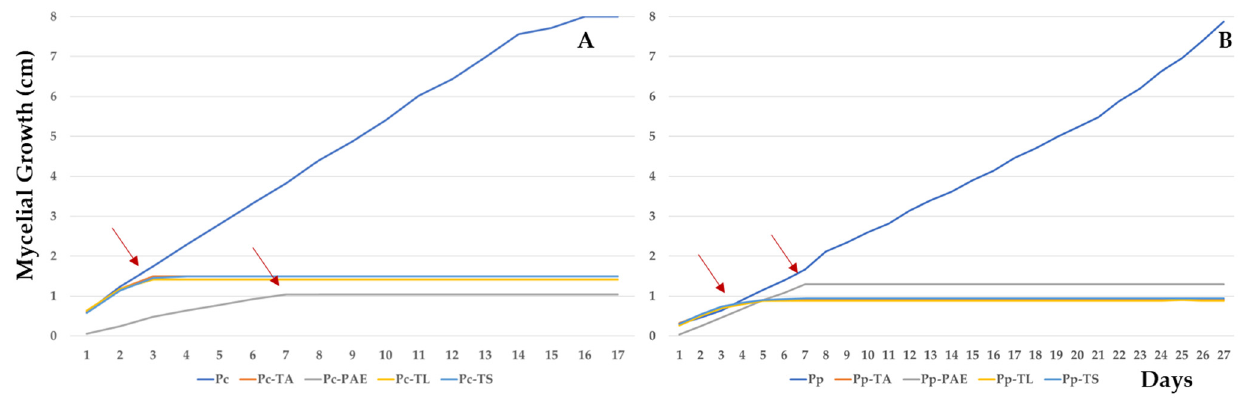
Figure 3. Mycelial growth of P. capsici (Pc) ( A ) and P. parasitica (Pp) ( B ) against T. aggressivum f. europaeum (TA), P. variotii (PAE), T. longibrachiatum (TL), and T. saturnisporum (TS), which peaked at 17 and 27 days, respectively. and 27 days,